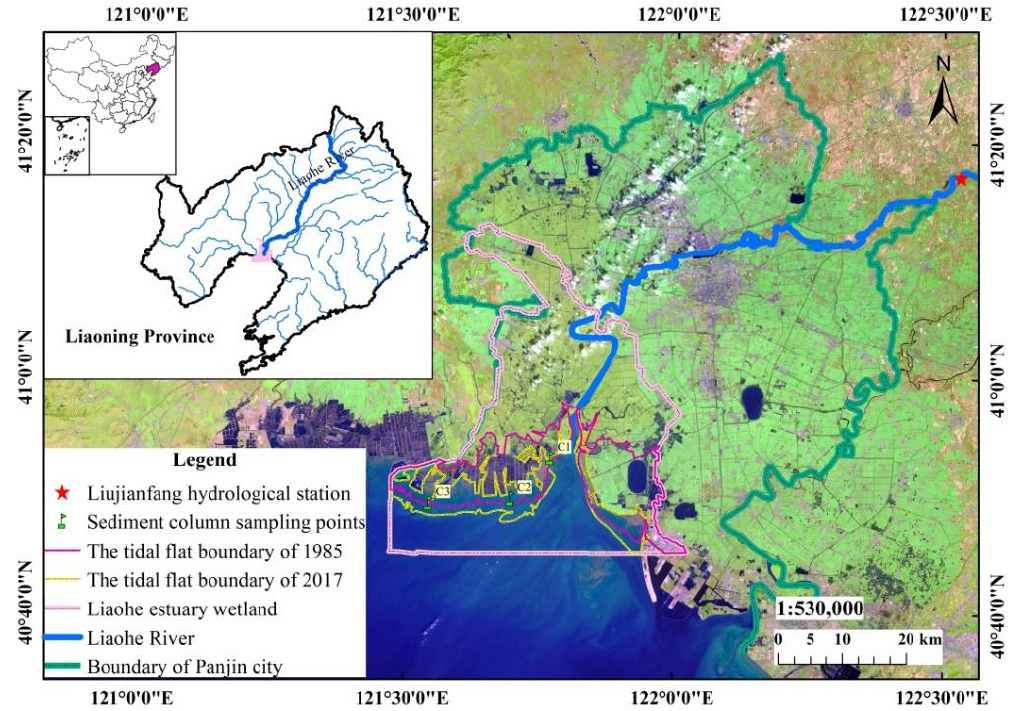
Figure 1. The location of the study area.